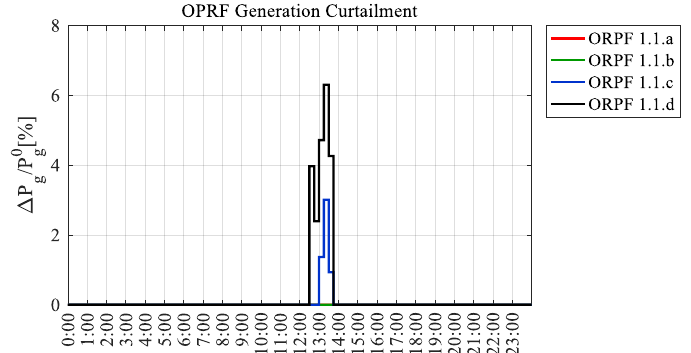
Figure 21. ORPF 1.1 results: DG’s real power curtailment.